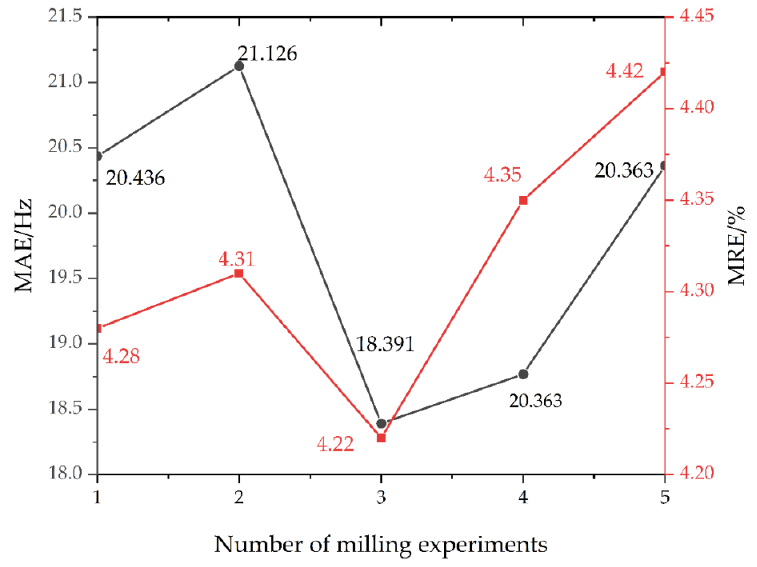
Figure 15. Error between the predicted results and true values; black line: MAE; red line: MRE.